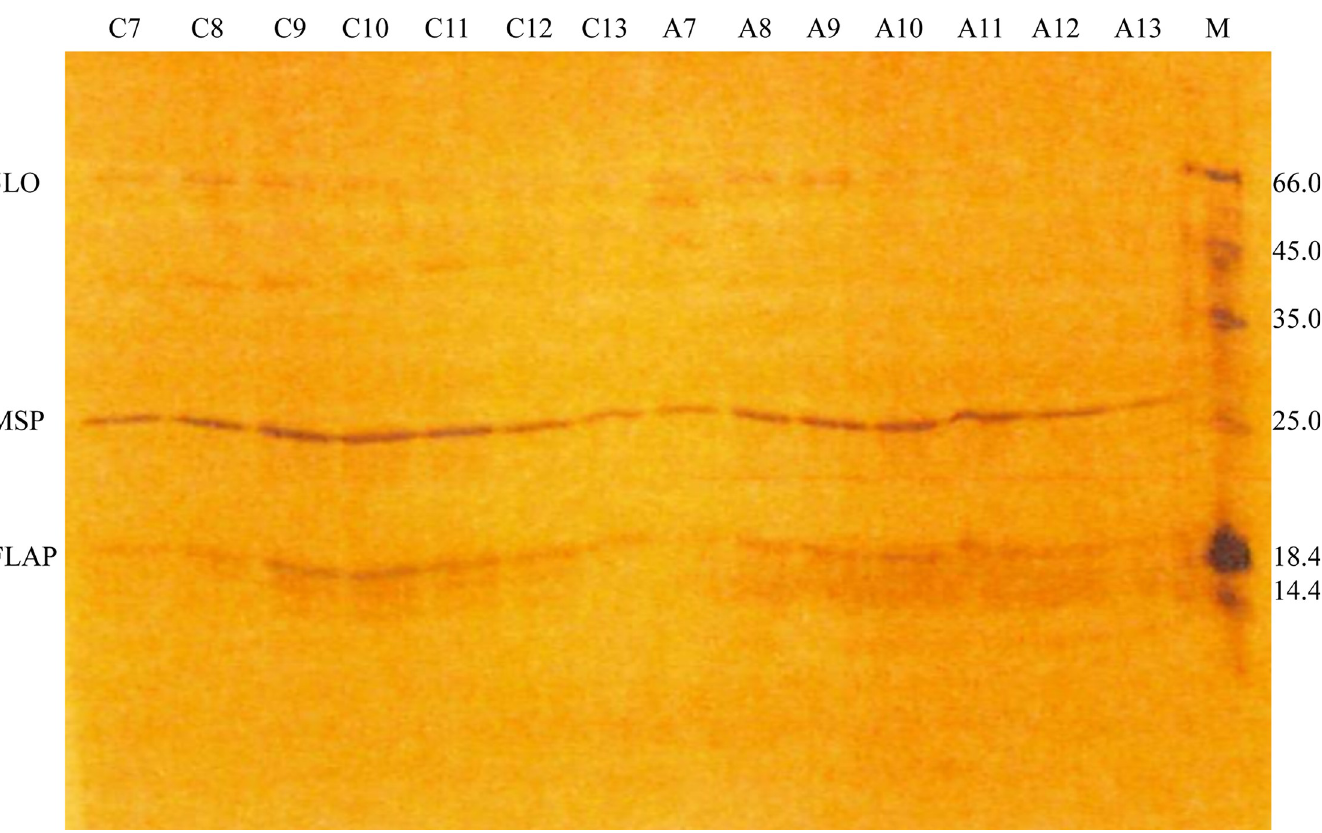
Fig 3. Either Ca 2+ or AA can induce 5LOFND-complex formation as shown by SDS-PAGE denaturing gel electrophoresis after sucrose gradient separation. For the Ca 2+ induced 5LOFNDCa-complex, seven fractions from the sucrose gradient were loaded on the gel (Lanes C7-C13). Out of these, fraction C9 shows the most intense bands of FLAP, MSP and 5LO. For the AA induced 5LOFNDAA-complex, seven fractions from the sucrose gradient were loaded on the gel (Lanes (A7-A13). Out of these, fraction A9 shows the most intense bands of FLAP, MSP and